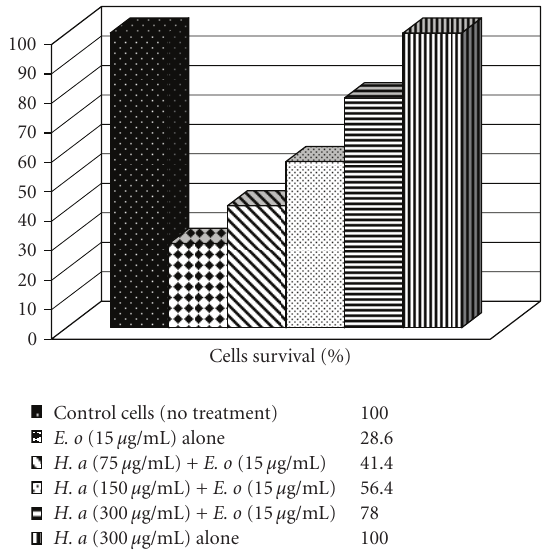
Figure 1: E ff ects of Hibiscus aethiopicus L. extract against the cytotoxic actions of E. ocellatus venom on C 2 C 12 muscle cells. E. o: Echis ocellatus; H. A: Extract of H. aethiopicus